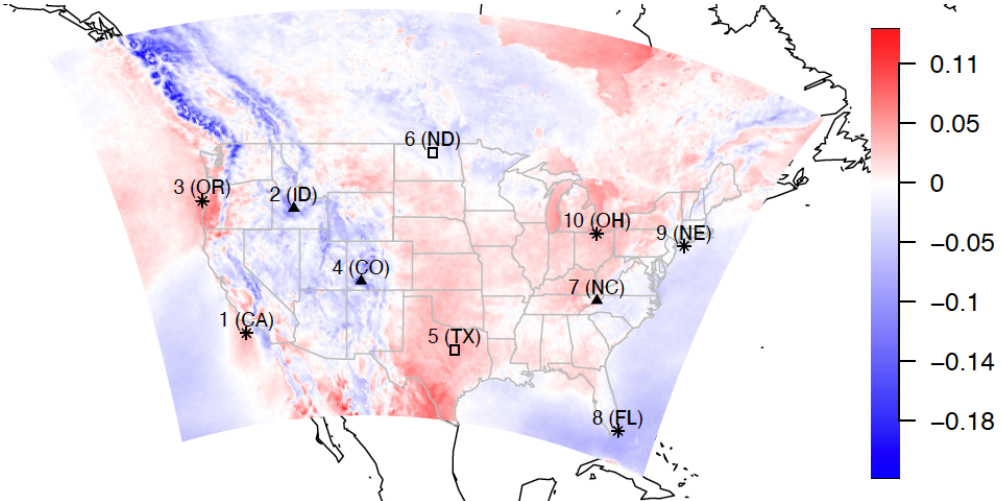
Figure 1. Studied locations are the Californian coast (location 1), Idaho (ID) inland (location 2), Oregon (OR) coast (location 3), Colorado Mountain (location 4), Texas southern Great Plains (SGP; location 5), North Dakota Great Plains (location 6), southeastern mountains (location 7), Florida (FL; location 8), northeastern coast (location 9), and Lake Erie, Ohio (OH; location 10). We use the ∗ symbol to denote an offshore location, (cid:78) to denote a mountain location, and (cid:3) to denote a plain location. The map is colored by the ratio of changes in the 10-year mean 95th percentile of the wind speed distribution projected by WRF and driven by the Community Climate System Model 4 (CCSM4). See the data description in Sect.